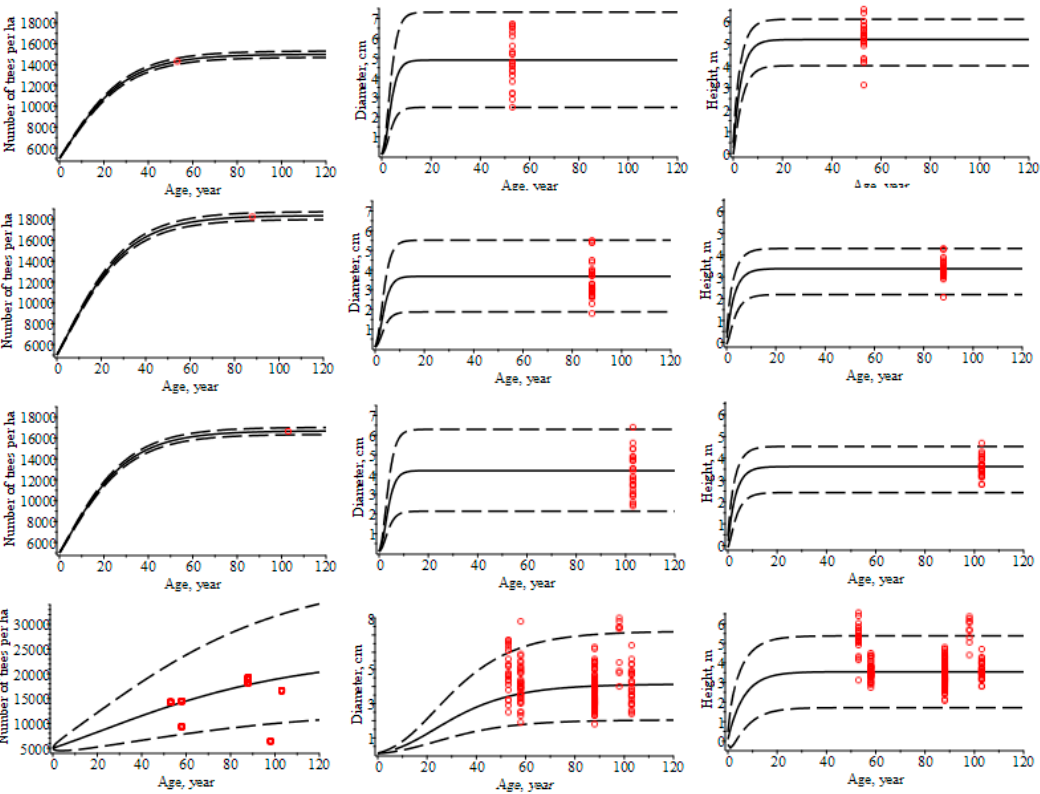
Figure 5. Mean and 5% and 95% quantiles trajectories with observed data points of the tree density, diameter, and height: mean trajectory, solid line; 5% and 95% quantiles trajectories, dashed lines; first row, mixed-effects scenario for the first stand; second row, mixed-effects scenario for the second stand; third row, mixed-effects scenario for the third stand; last row, fixed effects scenario for all stands; and validation dataset, red circles.